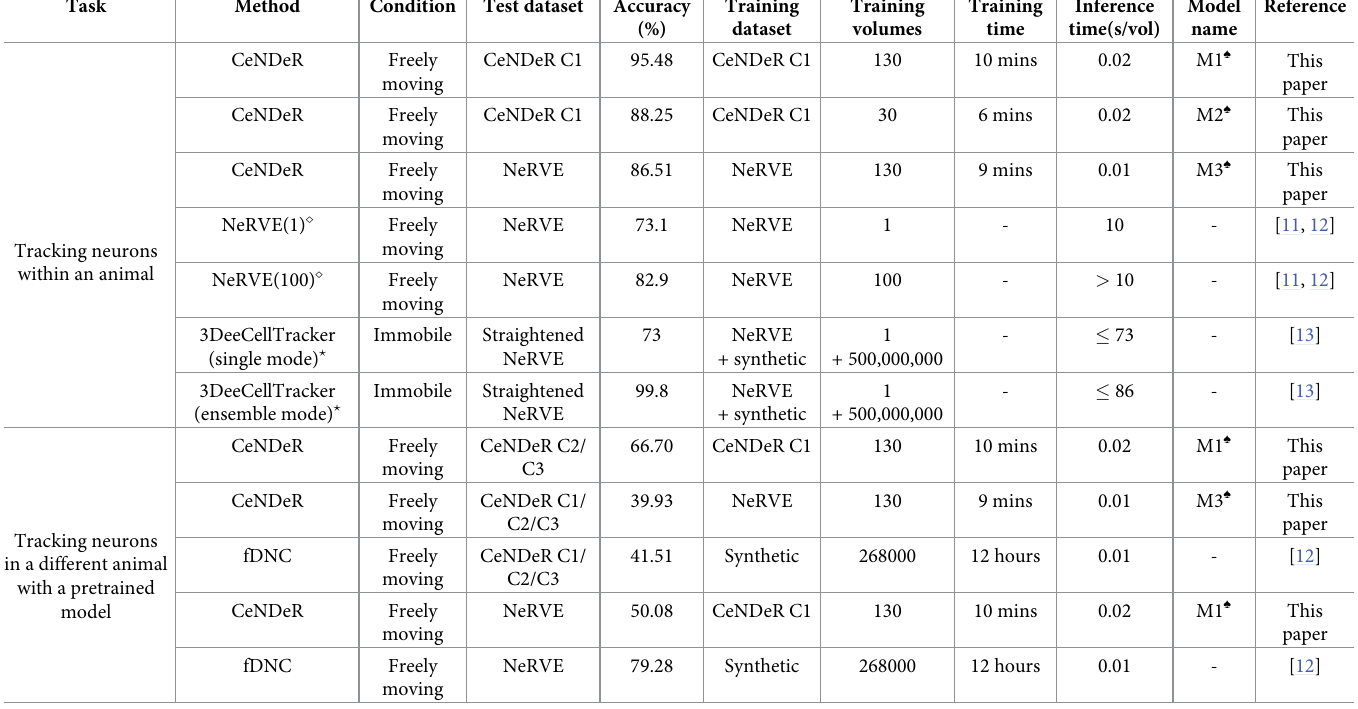
Table 4. Tracking methods comparison. We summarize the performances of four different methods in tracking neurons. The task is to assign neurons with consistent digital IDs across a 4-D imaging dataset. “s/vol” refers to seconds per volume.